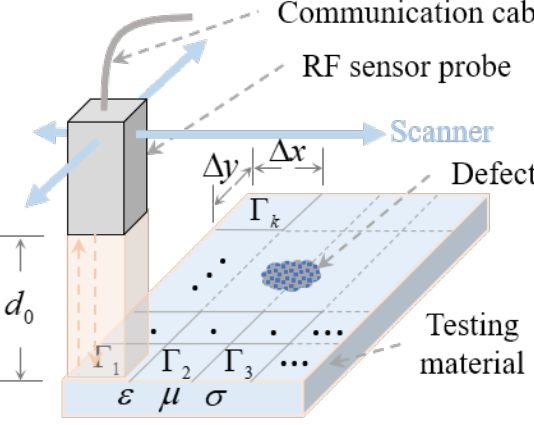
Figure 2. Diagram of a NRI system for NDT.